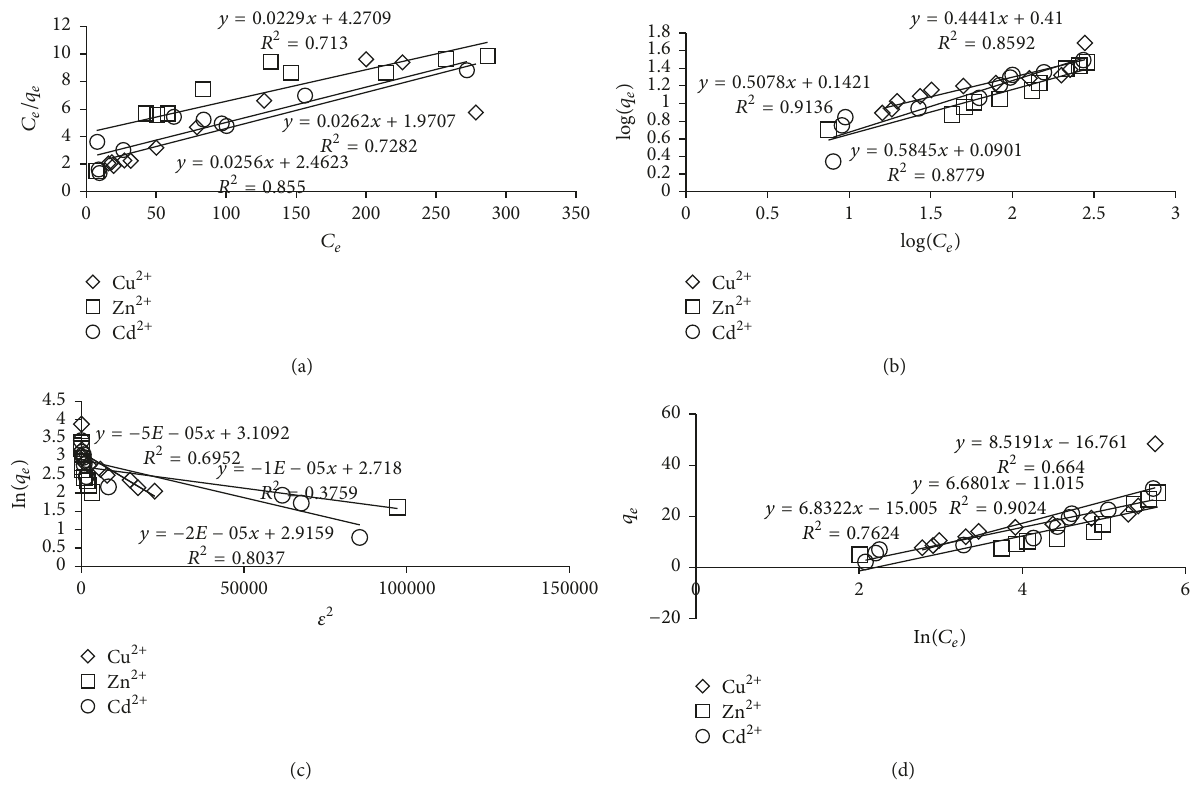
Figure 9: Plot for (a) Langmuir, (b) Freundlich, (c) Dubinin-Radushkevich, and (d) Temkin isotherm models for the removal of heavy metal ions by the zirconium-based ferromagnetic